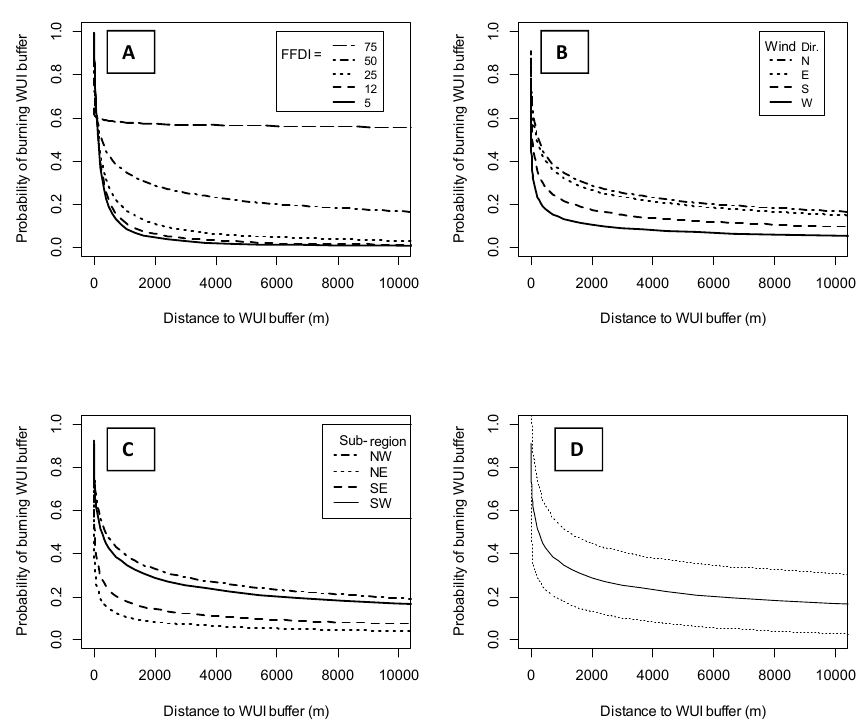
Fig. 4. Model predictions for the probability of burning the WUI buffer: (A) for different FFDI values, with west wind direction and northwest subregion; (B) for each wind direction, with FFDI = 50 and northwest subregion; (C) for each subregion with FFDI = 50 and wind direction = west; (D) Mean (solid) and 95% confidence interval (dotted) for FFDI = 50, west wind direction and northwest